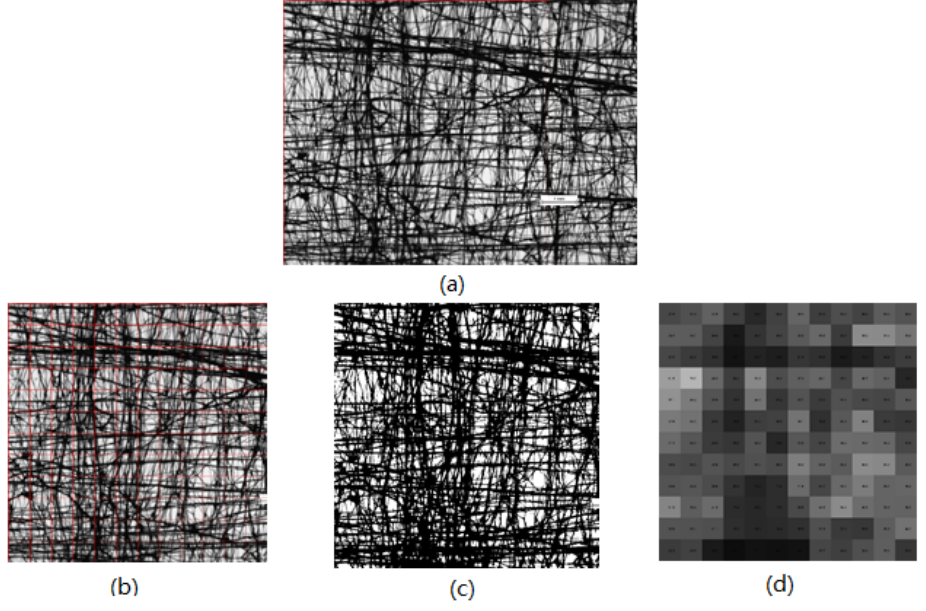
Figure 3. ( a ) Original image of sample MEFTEX 10 (1200 × 1600 px; 7.69 mm × 10.26 mm), ( b ) image crop and sub windows of size 100 × 100 px (0.64 mm × 0.64 mm), ( c ) binary image ( d ) map of porosity.